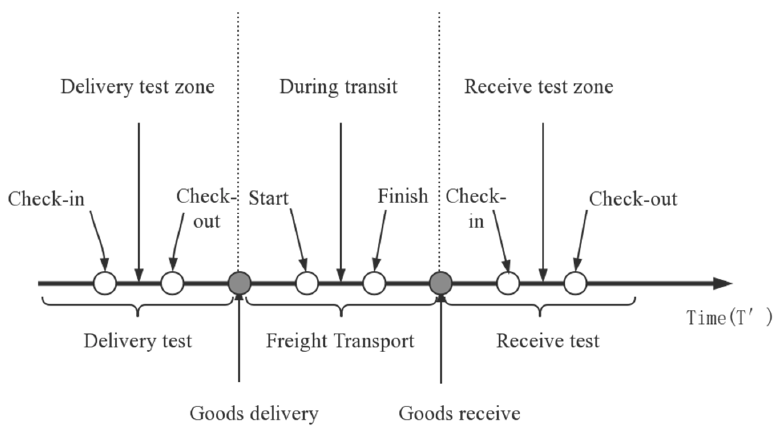
Figure 4. Outsourcing company A, B entering or leaving the plant transportation process sequence diagram.